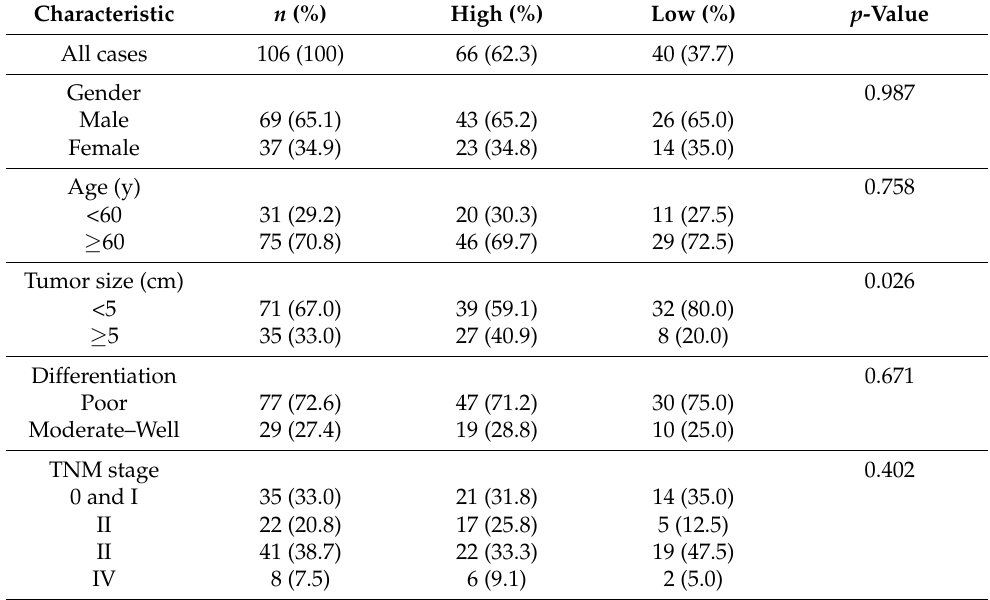
Table 1. Relationship between plasma tRF-27 levels and the clinicopathological factors of preoperative gastric cancer